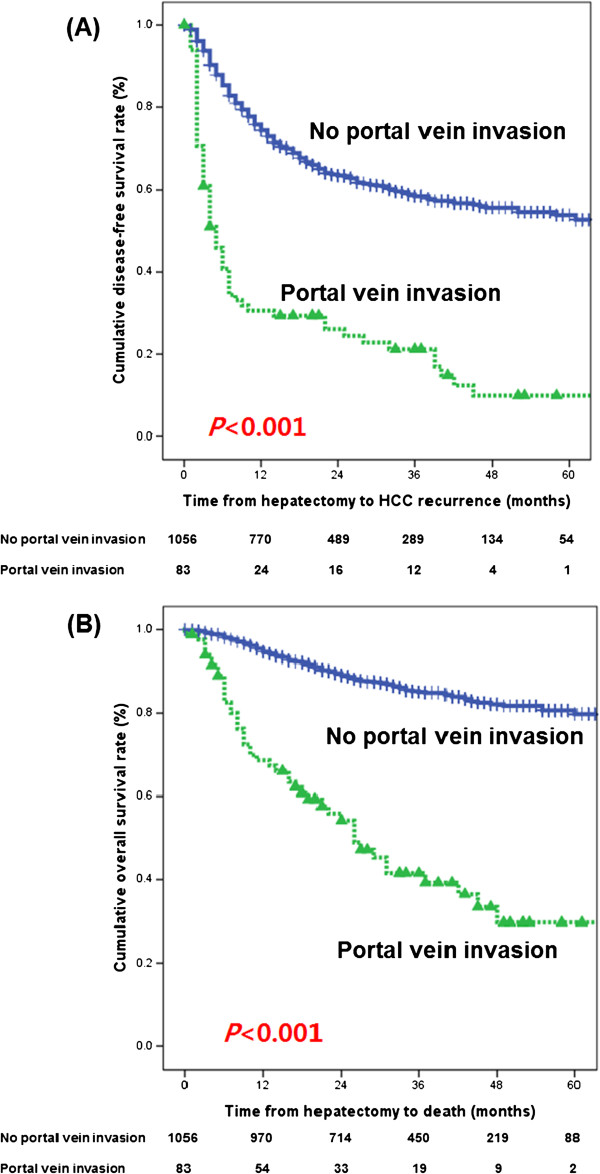
(A) Disease-free survival rate and (B) overall survival rate in HCC patients according to portal vein invasion. The disease-free survival curve and overall survival curve in HCC patients with malignant portal invasion were inferior to those in HCC patients without portal vein invasion.